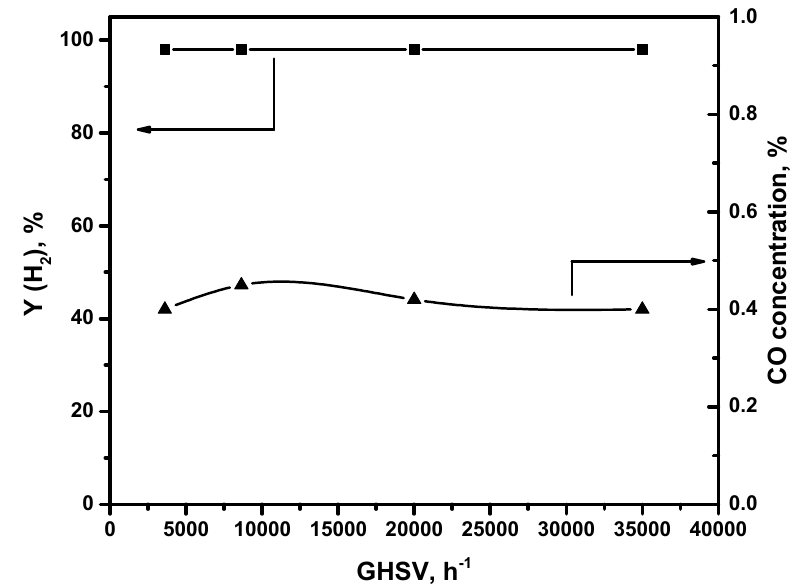
Figure 5. E ff ect of GHSV on H 2 yield ( (cid:4) ) and outlet CO concentration ( (cid:78) ) over CuO-CeO 2 / γ -Al 2 O 3 Figure 5. Effect of GHSV on H 2 yield ( ■ ) and outlet CO concentration ( ▲ ) over CuO-CeO 2 / γ -Al 2 O 3 catalyst for HCOOH decomposition. Reaction conditions: p = 1 atm, T = 300 ◦ C, X (HCOOH) = 100%. catalyst for HCOOH decomposition. Reaction conditions: p = 1 atm, T = 300 ° С , X (HCOOH) = 100%. Inlet composition, vol.%: N 2 :HCOOH = Inlet composition, vol.%: N 2 :HCOOH = 75:25.